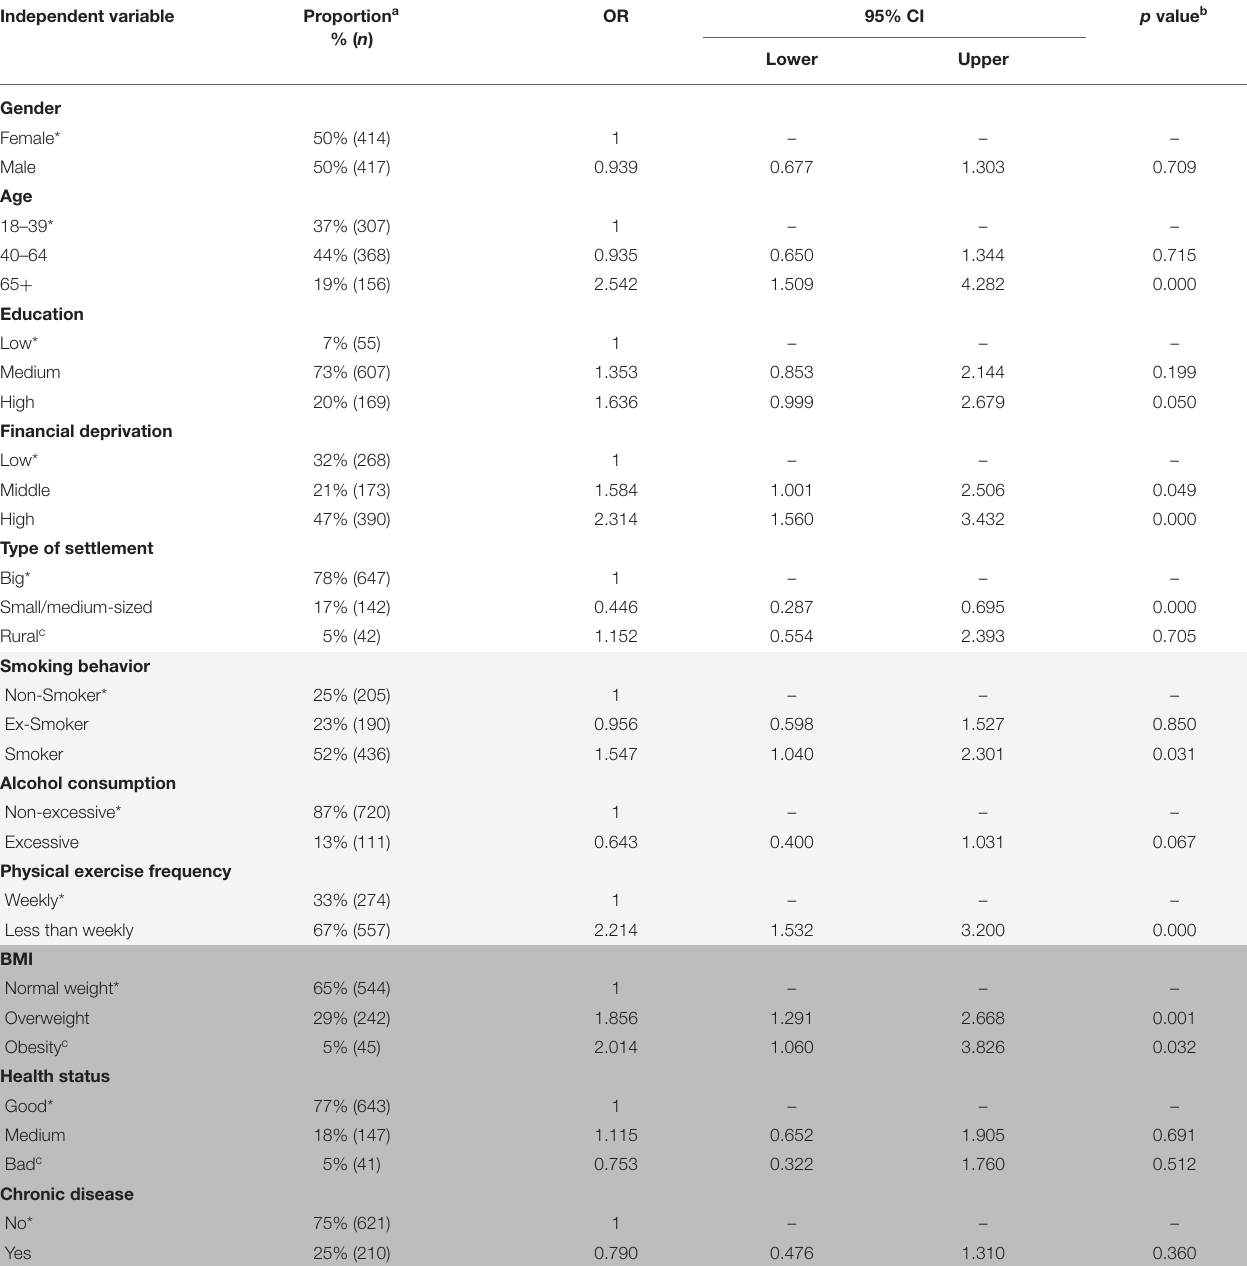
TABLE 4 | Associations of MHL and sociodemographic characteristics, health behavior, and health outcome. Independent